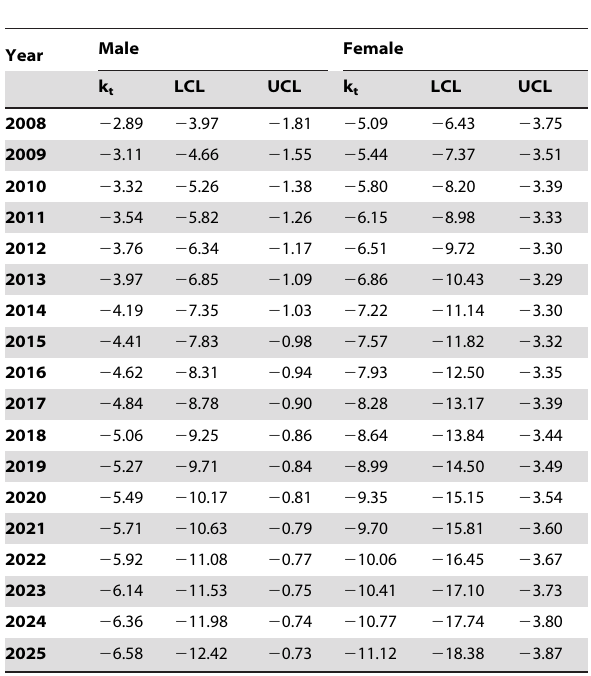
Table 4. Forecasts of mortality index k from (0, 1, 0) model,